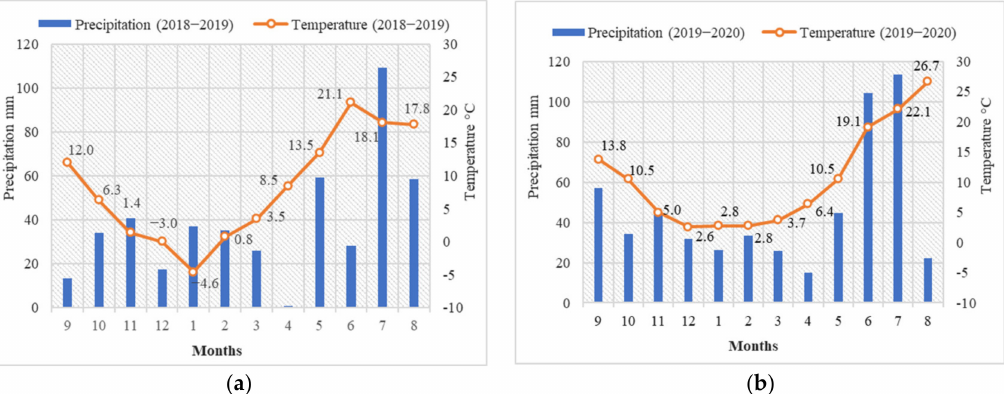
Figure 1. Monthly mean temperature and precipitation at the experimental sites during the periods 2018–2019 ( a ) and 2019–2020 ( b